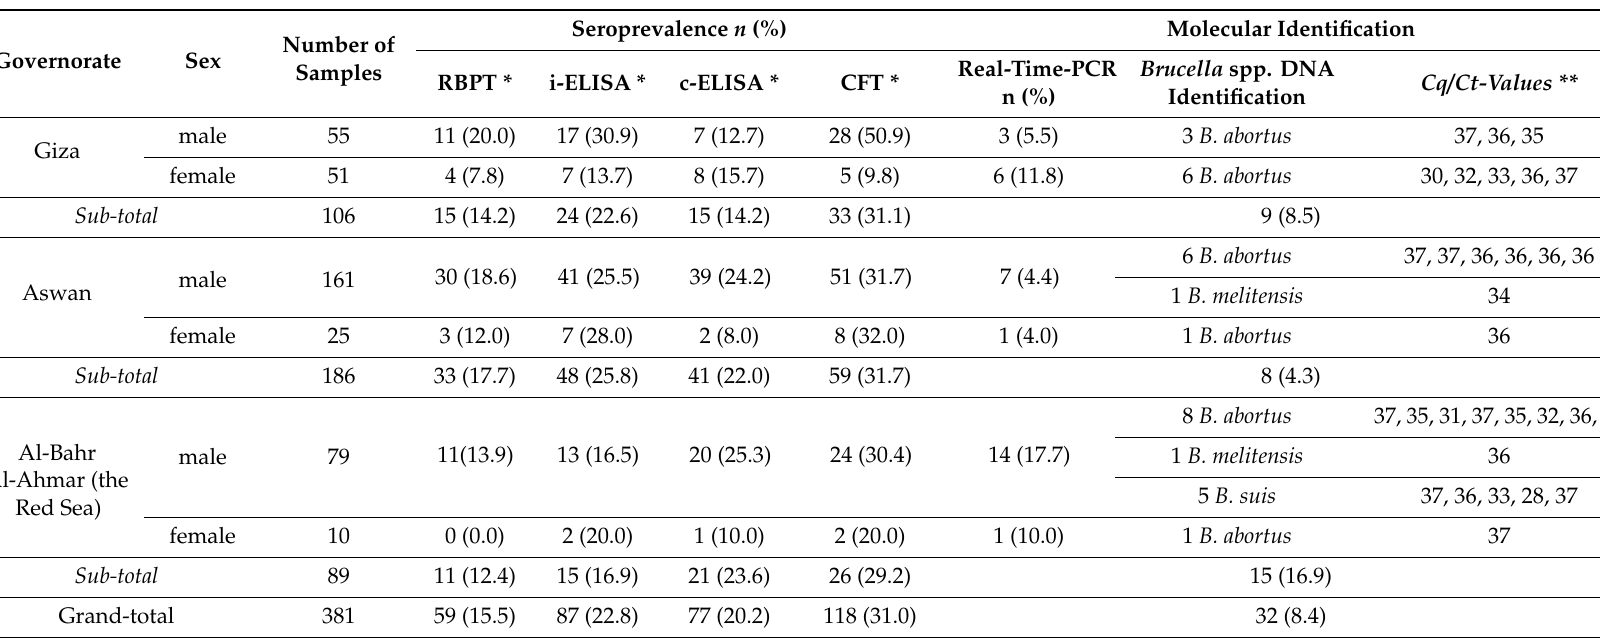
Table 2. Seroprevalence and molecular identification of Brucella DNA in camel sera collected from Giza, Aswan and Al-Bahr Al-Ahmar (the Red Sea) governorates, Egypt.